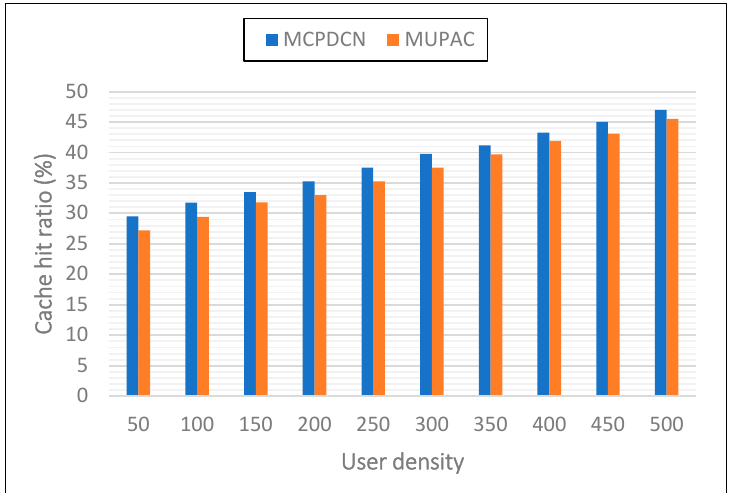
Figure 9. MUPAC vs MCPDCN (cache hit ratio) in terms of user density.